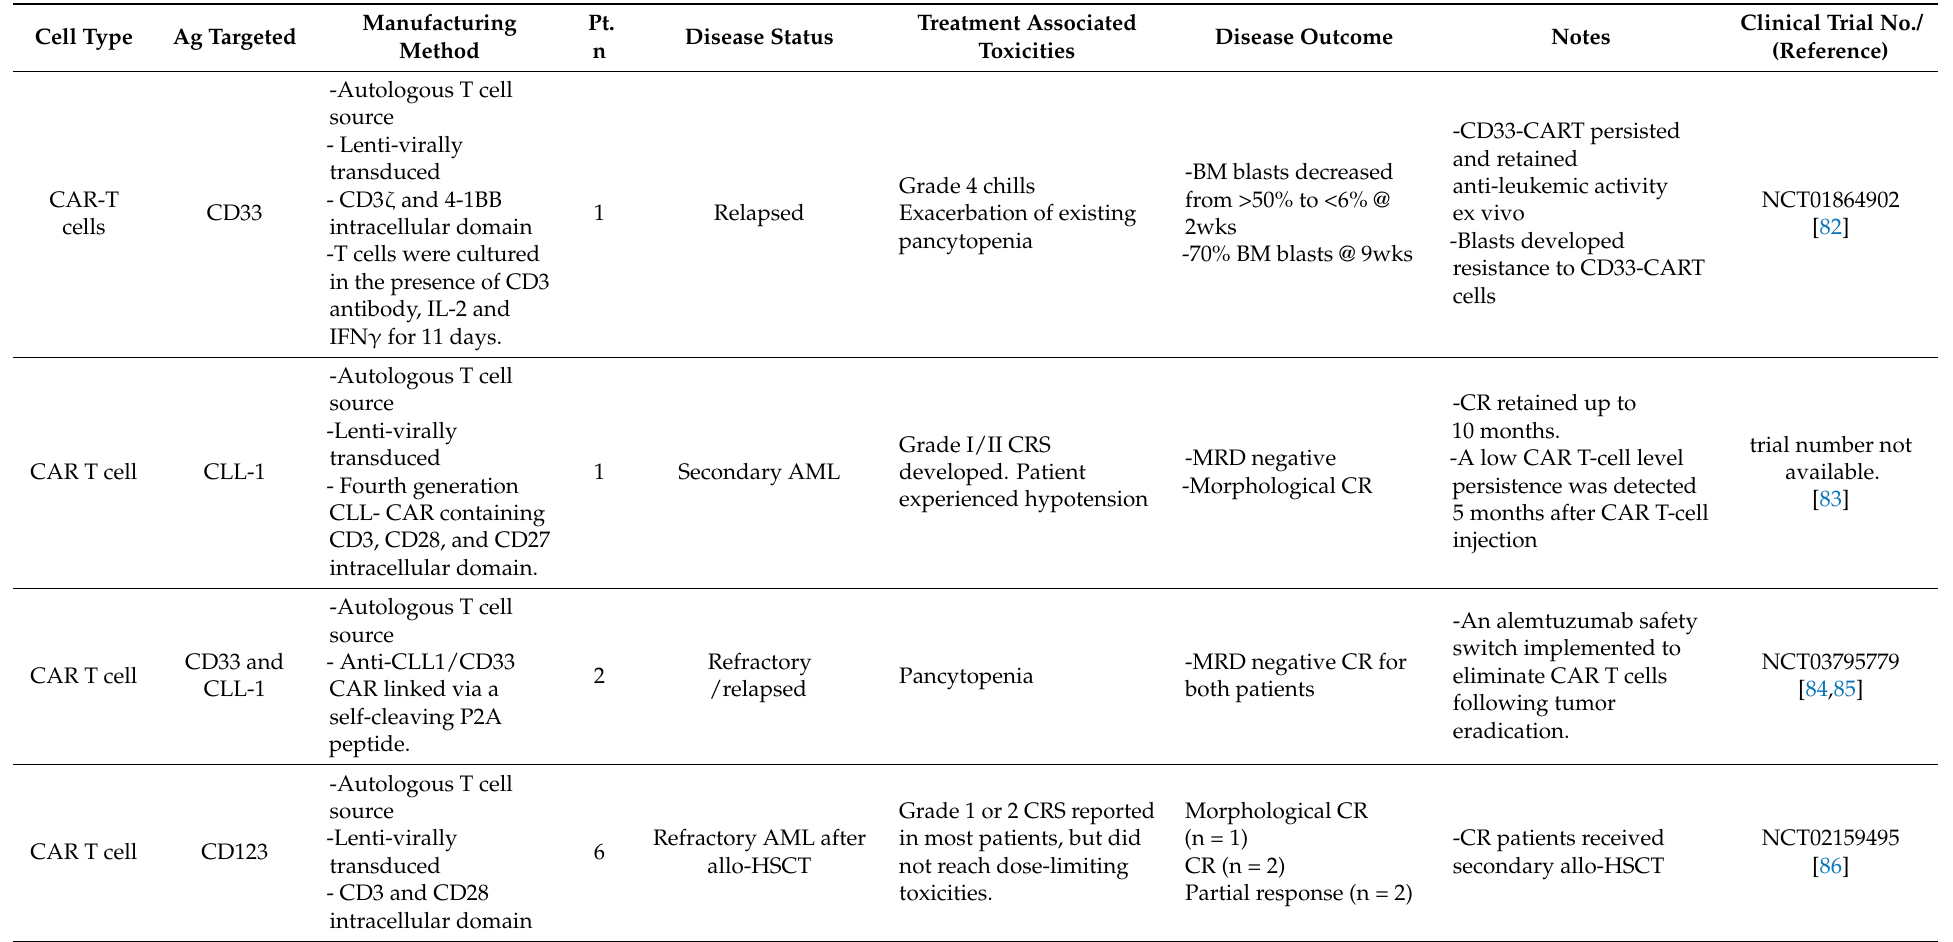
Table 5. Adoptive cellular therapies used to treat AML patients in clinical